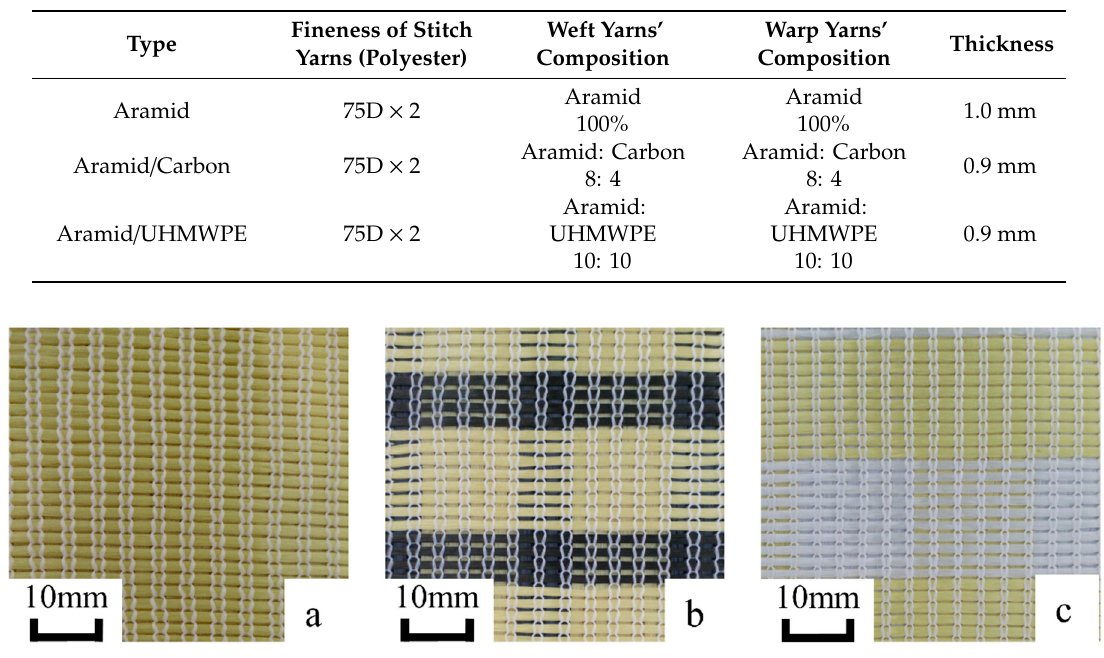
Figure 2. Three types MBWK fabrics: ( a ) Aramid; ( b ) Aramid/carbon; ( c ) Aramid/UHMWPE. Table 2. Parameters of three types MBWK fabrics.